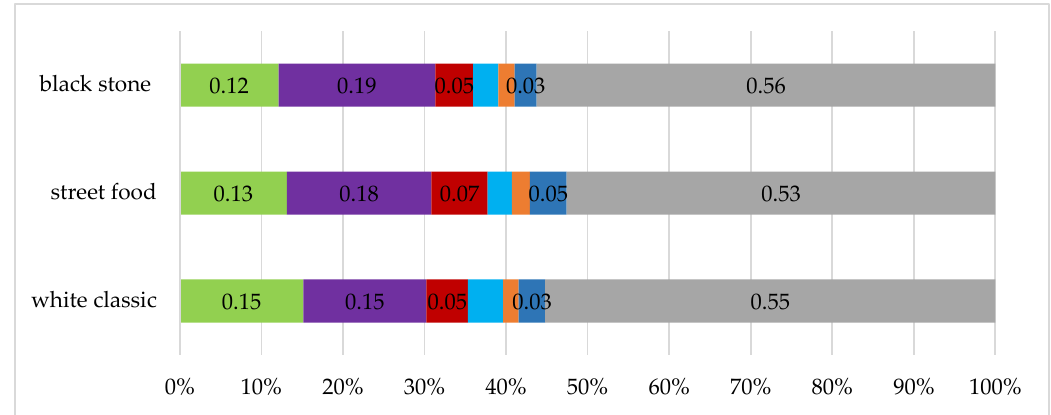
Figure 11. Microemotions recorded during the evaluation of individual visual versions of the food.